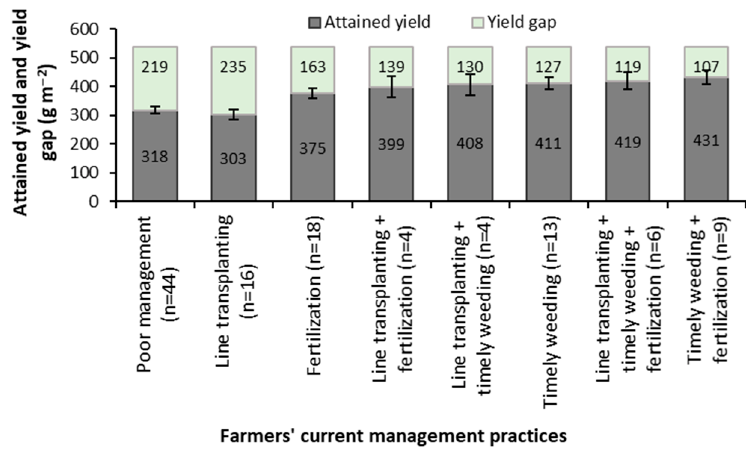
Figure 3. Attained yield (g m − 2 ) and yield gap under different farmers’ current management practices (FP), Doho 2019. Error bars are twice standard error of means. Poor management is where none of the components of recommended agronomic practices that were recorded was applied. The other management practices included one or more of the components of recommended agronomic practices applied. n is the number of farmers who applied the different management practices.